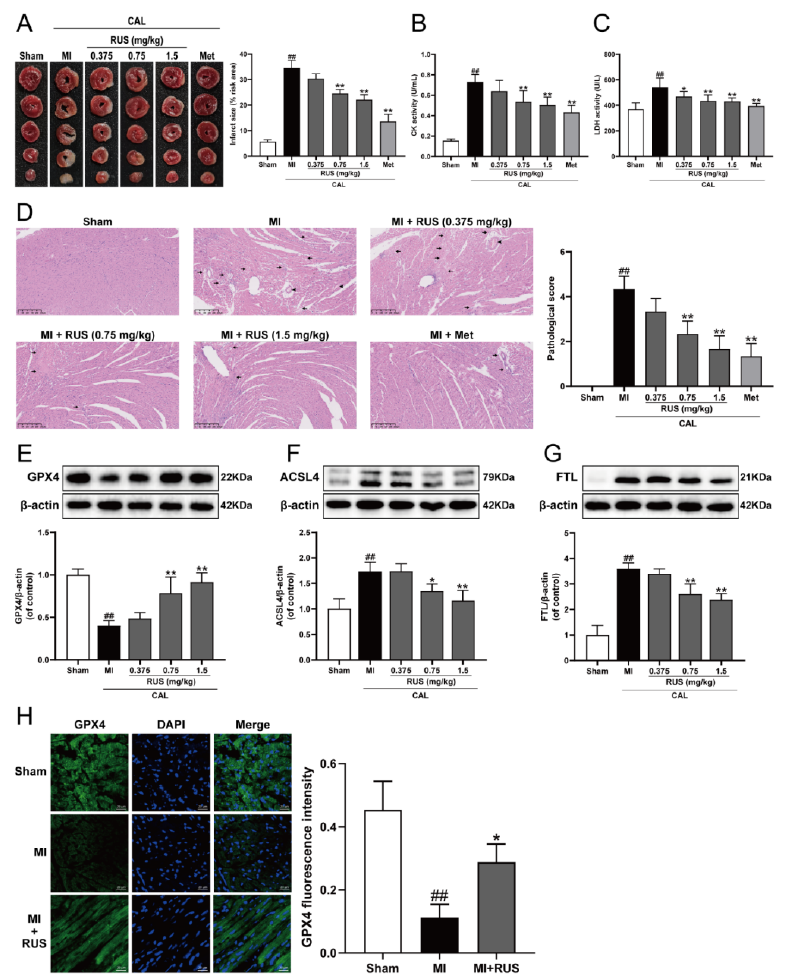
Figure 1. RUS effectively alleviated myocardial injury and inhibited ferroptosis in MI mice. ( A ) TTC staining images of the heart infarct size ( n = 3). The serum activity of ( B ) CK and ( C ) LDH ( n = 6). ( D ) HE staining images of the heart tissues (scale bar, 250 µm, n = 3). Histopathological changes are indicated by arrows (inflammatory cellular infiltration) and arrowheads (hyperemic blood vessels). Western blotting analysis of ( E ) GPX4, ( F ) ACSL4, and ( G ) FTL in the heart tissues ( n = 3–4). ( H ) Immunofluorescence images of GPX4 in the heart tissues of sham, MI and MI treated with 0.75 mg/kg RUS groups (scale bar, 20 µ m, n = 3). Results were expressed as mean ± SD. ## p < 0.01 vs. the sham group, * p < 0.05, ** p < 0.01 vs. the MI